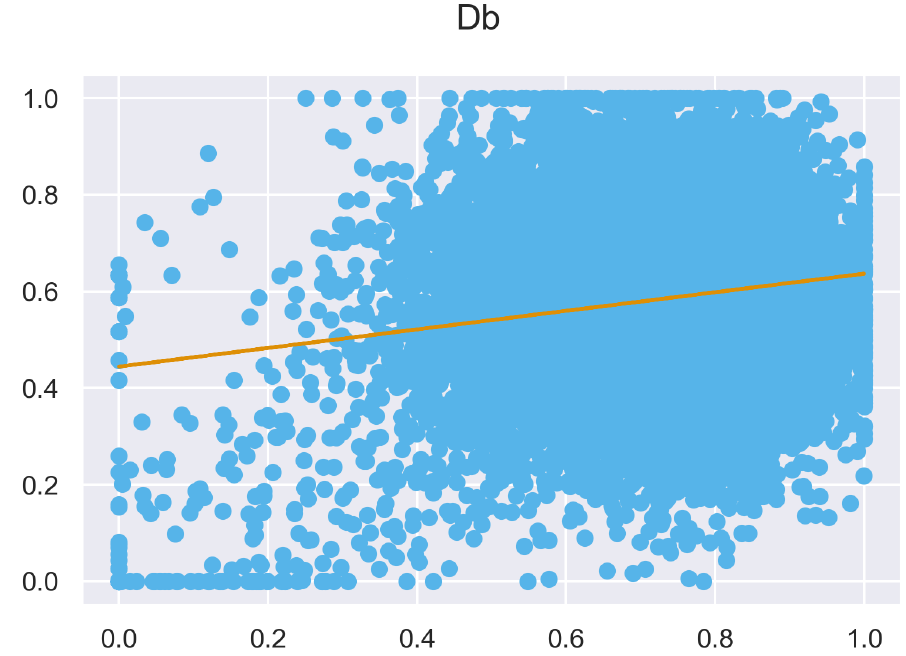
Figure A7. ULS and TLS D b regression at 0.5 m grid size.